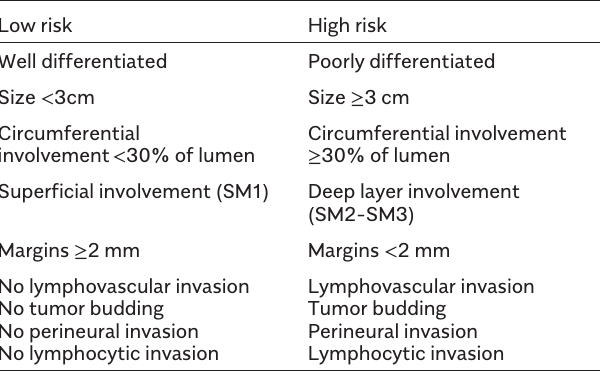
Table 1. Criteria for Low- or High-Risk Rectal Cancer and Lymph Node Metastasis Low